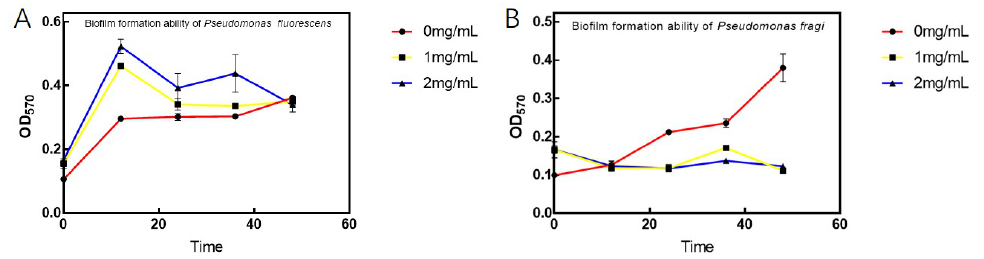
Figure 8. Antibacterial effects of D. algida on the biofilm during the development stage of the target Pseudomonas , where ( A , B ) are the absorbance values of P. fluorescens and P. fragi , respectively, under different MIC. The data are shown as mean ± SD ( n = 3).